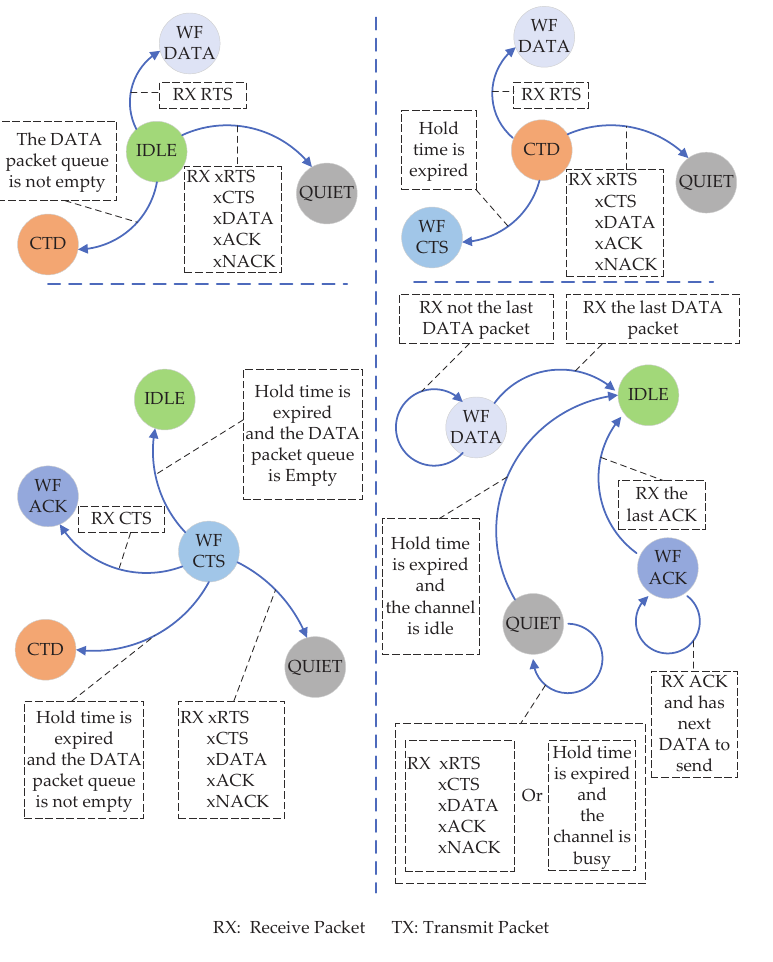
Figure 9. State transition rules of